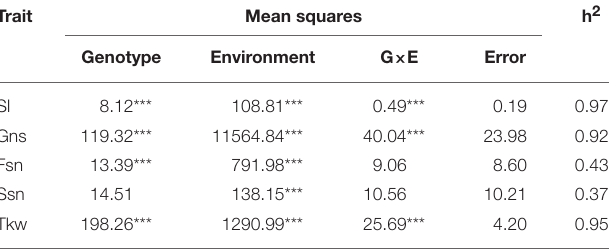
TABLE 3 | Correlation analyses among five spike-related traits using average data.